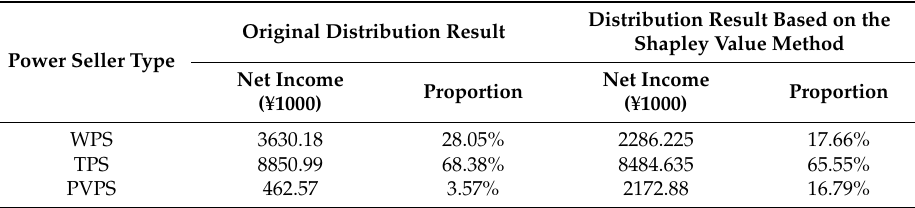
Table 7. The distribution results based on the Shapley value method.